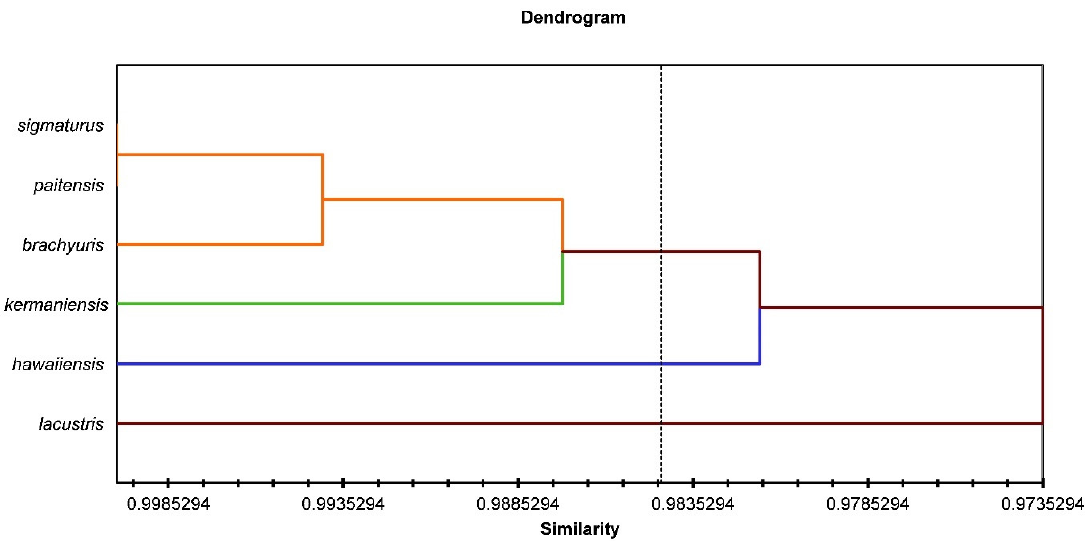
Figure 4. Hierarchical cluster analysis for six species of Mylonchulus .